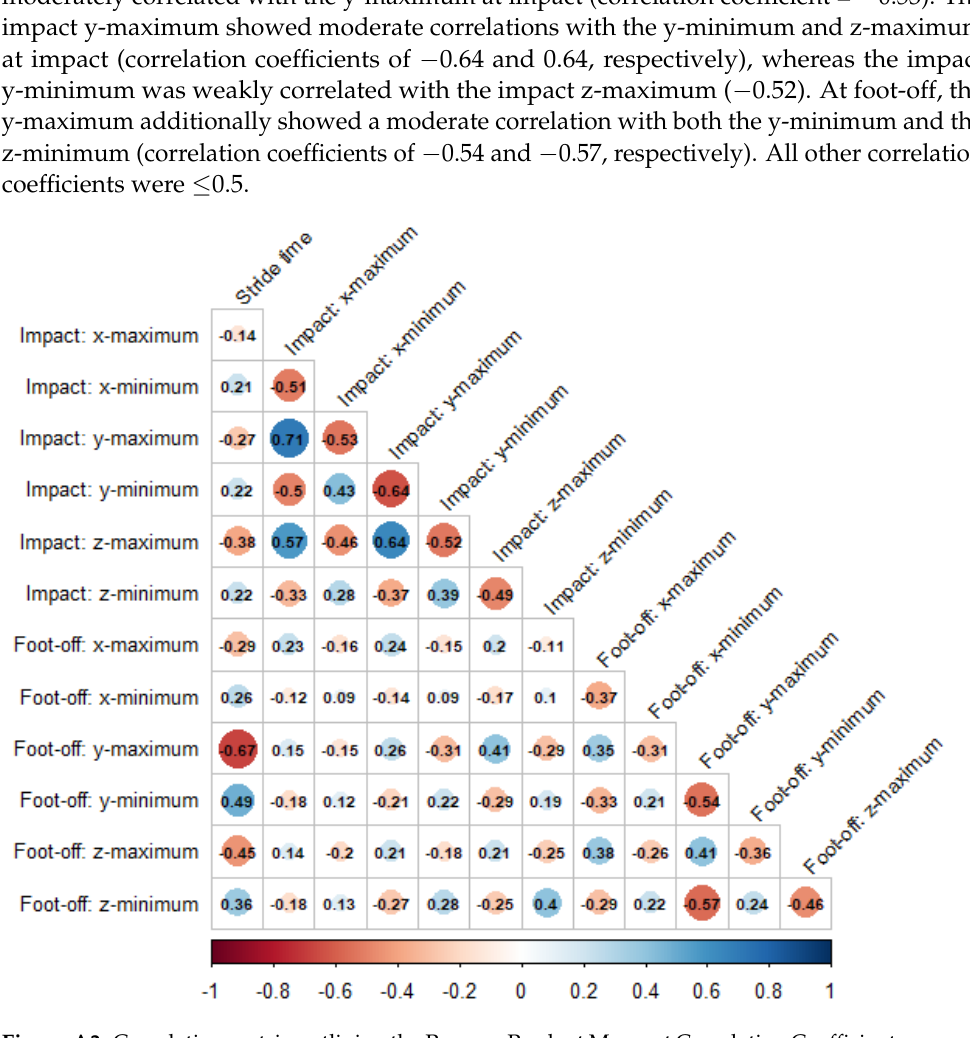
Figure A2. Boxplots illustrating minimum and maximum foot-off accelerations per shoe – surface combination. The p -values for pairwise comparisons (with Bonferroni correction) are provided in Supplementary Table S7. Please note that ‘*’ indicates ‘multiplied by’.